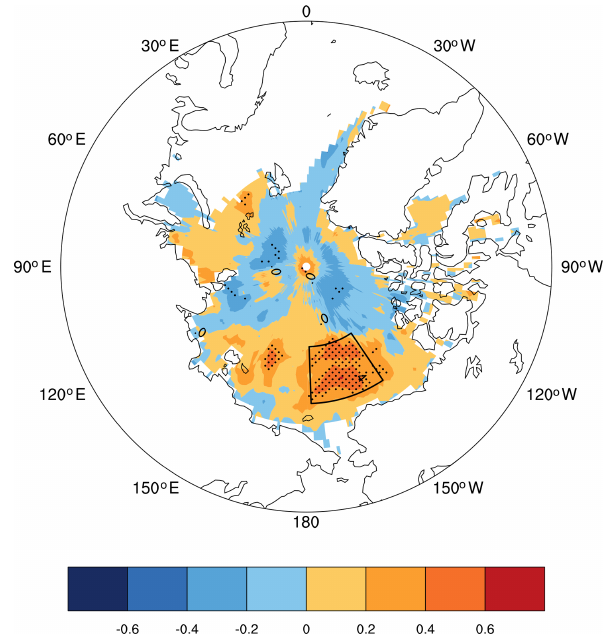
Figure 3. The correlation coefficient (CC) between the HDJ NCP and September–October sea ice concentration from 1979 to 2015, after detrending. The black dots indicate CCs exceeding the 95% confidence level ( t test). The black box represents the selected Beaufort